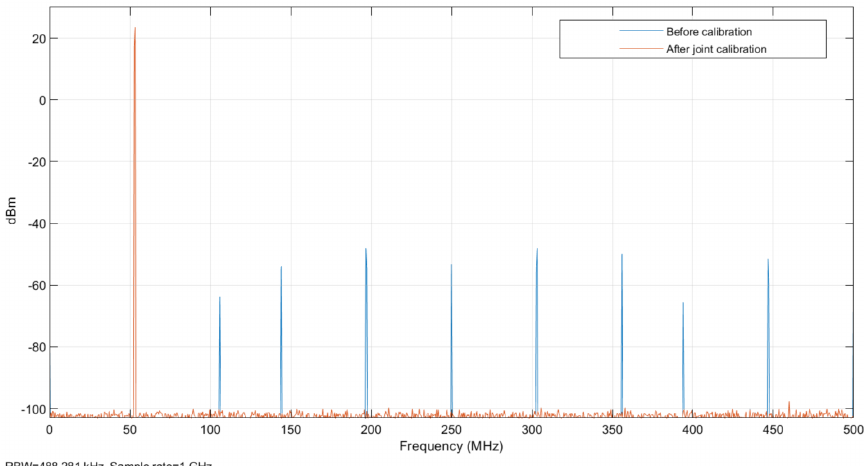
Figure 9. Spectrum of the TIADC model calibrated by offline LS